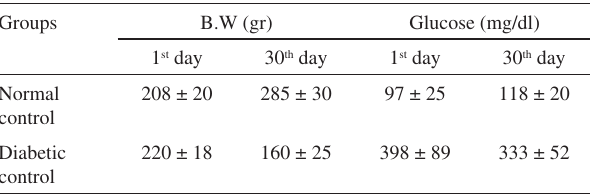
Table 5 - Changes in body weight and blood glucose in normal and diabetic control animals.